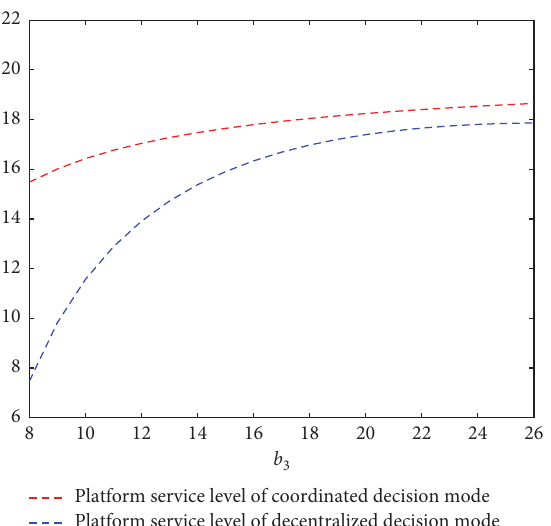
Figure 4: Influence of b 3 on the platform service level.